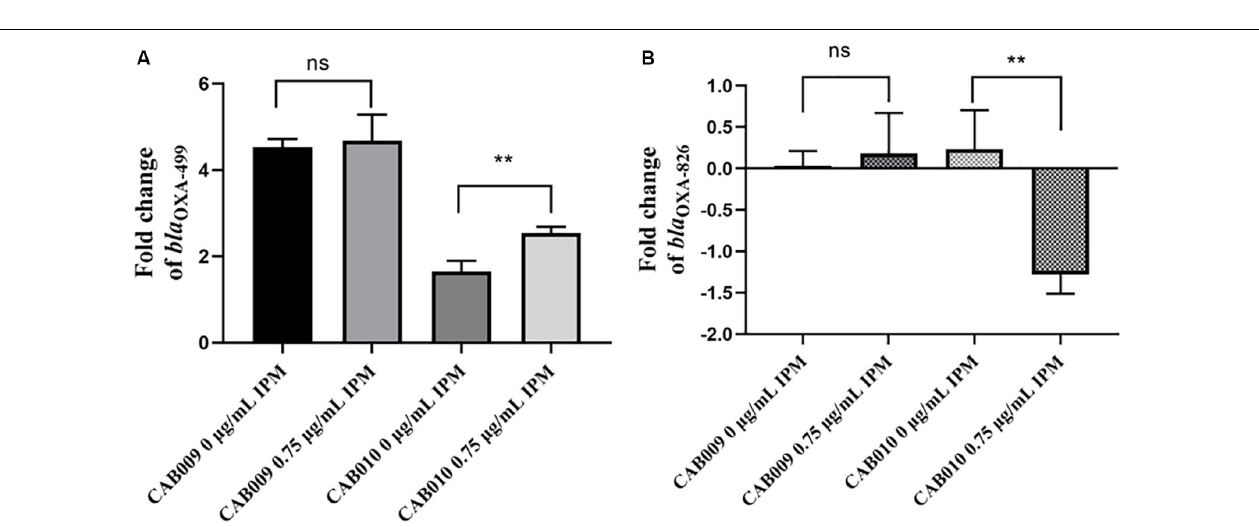
FIGURE 2 | Locations of mutations in the carbapenem-resistant mutants CAB009 and CAB010 (boxed in blue). The start codon (boxed in red), the transcription initiation site (boxed in gray), and the − 10 and − 35 regions (boxed in green) are also indicated.